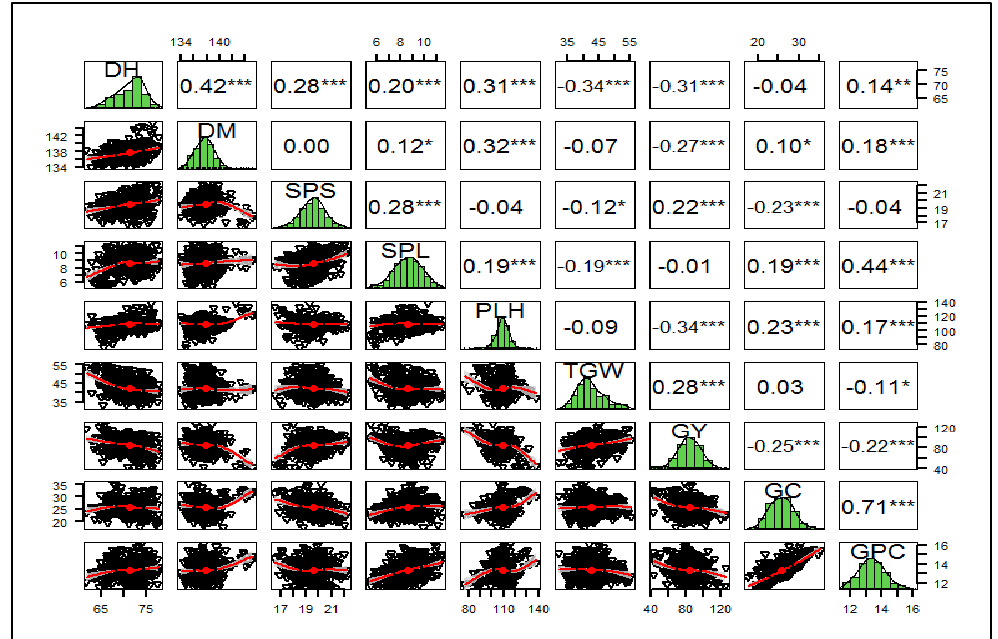
Figure 2. Phenotypic (above diagonal) correlation coefficients, distribution (diagonal), and scatterplot with regression curve (below diagonal) of 11 quantitative traits for the 420 durum wheat genotypes. Critical values for Pearson’s correlation coefficient are 0.1 002 at 0.05%, 0.13 at 0.01% and 0.17 at 0.001. “***” = significant at p < 0.001; “**” = significant at p < 0.01; “*” = significant at p < 0.05.